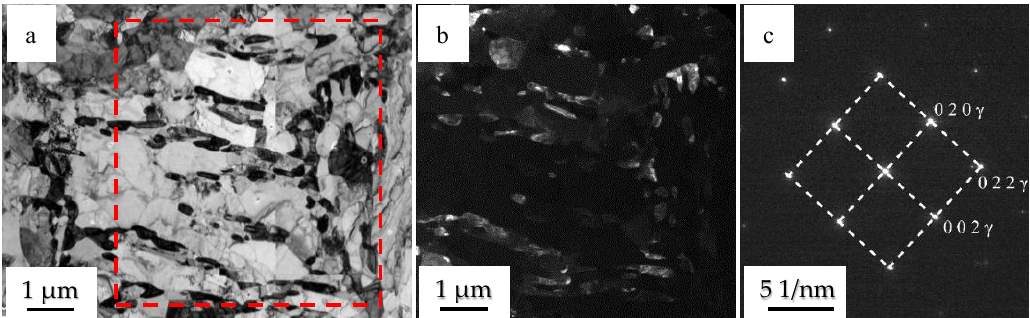
Figure 3. ( a ) Bright-field TEM images of retained austenite in the studied steel after the two-step intercritical treatment before tempering; ( b ) dark-field TEM images of retained austenite for the red rectangle area; ( c ) corresponding diffraction pattern of retained austenite under the zone axis of [1 0 0].